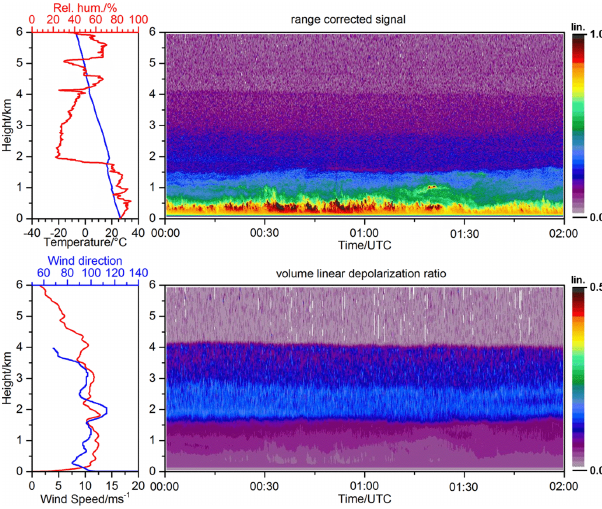
Figure 6. Same as Fig. 4 but for 27 June 2013, 00:00–02:00UTC. The radiosonde was launched on 27 June at